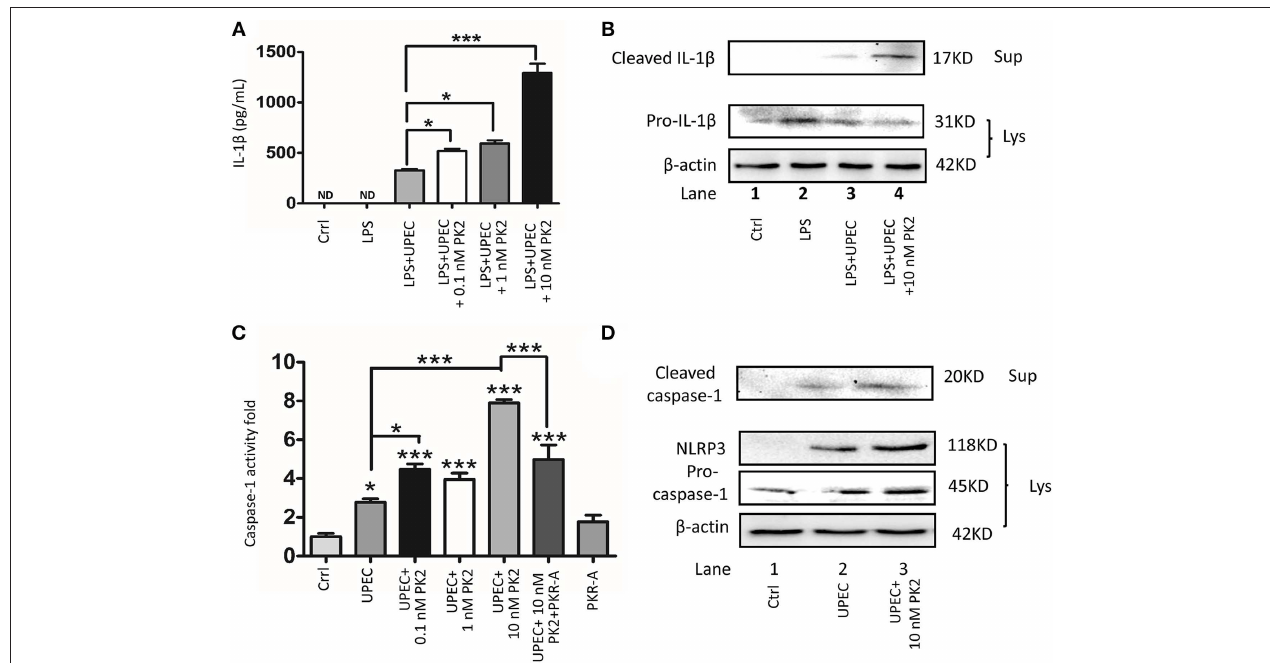
FIGURE 4 | PK2 promotes the NLRP3 pathway. (A) TM were primed with 1 µ g/mL LPS for 4h and then infected with UPEC (MOI 20) with or without various concentrations of PK2 (0.1nM, 1nM, and 10nM) for 2h. IL-1 β secretion in the supernatants was analyzed by ELISA. (B) TM and the supernatants were treated as described above. Whole-cell lysates and concentrated supernatants were analyzed by western blot with against IL-1 β and β -actin. (C) TM were infected with UPEC (MOI = 20) with or without PK2 for 2h. Whole-cell lysates were analyzed by caspase-1 activity assay. (D) TM were treated as described above. Whole-cell lysates were analyzed by western blot with antibodies against caspase-1 and concentrated supernatants were analyzed by western blot with antibodies against caspase-1, NLRP3, and β -actin. Ctrl, control; LPS, lipopolysaccharide; ND, no detected; Lys, cell lysates, Sup, supernatants. * P < 0.05, *** P < 0.001 (one-way